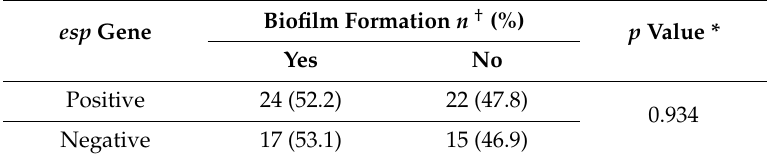
Table 3. The association between the esp gene and biofilm formation among clinical